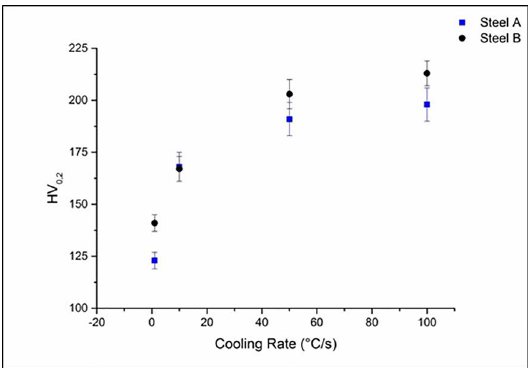
Figure 7. Vickers microhardness of steels A and B after cooling at described cooling rates.